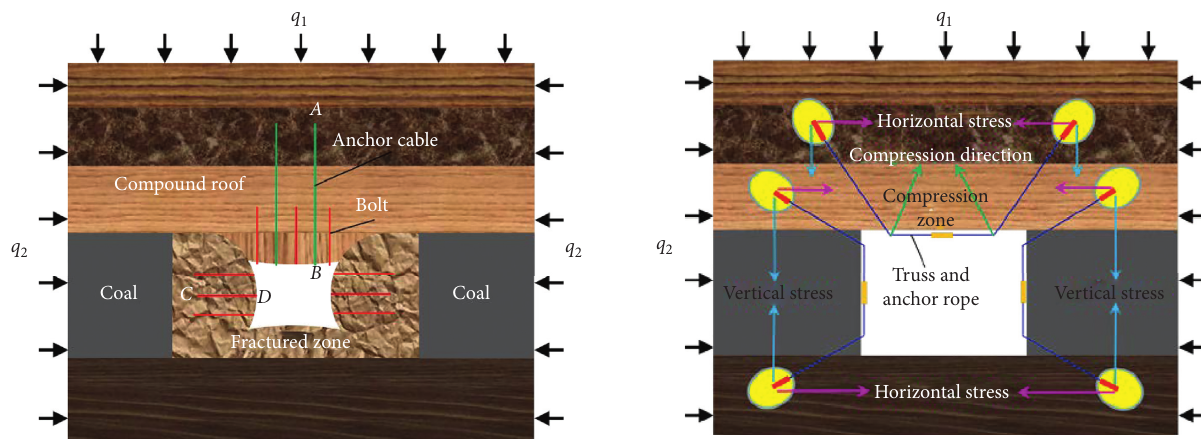
Figure 4: Features of the coal roadway support. Figure 5: The principle of the prestressed truss anchor cable